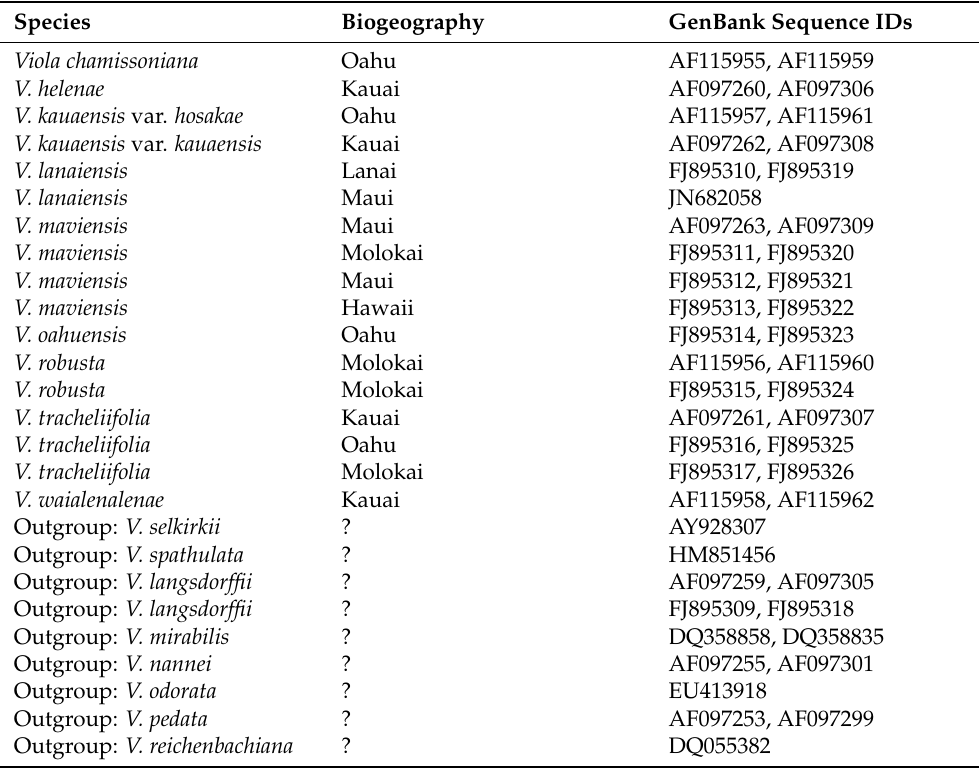
Table 6. Taxa, island biogeography, and GenBank sequence IDs of ITS1 and ITS2 for the combined dating and biogeographic analysis of subsect. Nosphinium . Biogeography for the outgroup was not coded and was entered as missing (“?”) in the analysis. Metadata for each sequence are available at